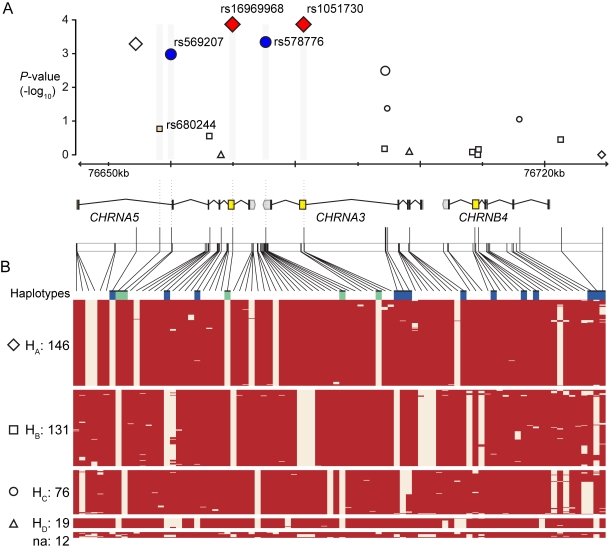
Haplotype Structure and Association Results in the Nicotinic α5, α3 and β4 Receptor Subunit Genes on Chromosome 15q24.(A) Genomic region of CHRNA5-A3-B4 transcription units on chr. 15 between 76,644,000 to 76,732,000 base pairs (NCBI Build 36). −log10(P value) plot of SNPs as a function of genomic position, with their P values (allele association values from chi square tests) observed in the early onset condition. The symbols indicate haplotype assignment (HA, HB, HC and HD) of the individual markers; open symbols indicate P values in the UT-WI cohorts and shaded symbols indicate P values in the combined UT-WI-LHS cohorts. The five SNPs used to assign haplotype status in the UT-WI-LHS cohorts are colored by haplotype affiliation: red (HA), (blue (HC) or beige (HB). (B) fastPHASE inferred haplotype structure of the region from unphased resequencing and genotypic data from 384 chromosomes (resequencing sample cohort). Haplotypes were assigned to groups using the 5 SNPs genotyped in the UT-WI-LHS cohorts (rs680244, rs569207, rs16969968, rs578776, and rs1051730). Haplotype counts for HA, HB, HC, HD and not assigned (na) are shown on the left, and the positions of SNPs genotyped in the UT-WI cohorts are indicated above the haplotypes by blue and in the UT-WI-LHS cohorts by green indicators.